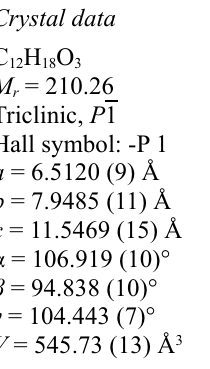
A packing diagram for the title compound. The O—H···O interactions are depicted by dashed lines. 3-Hydroxyadamantane-1-acetic